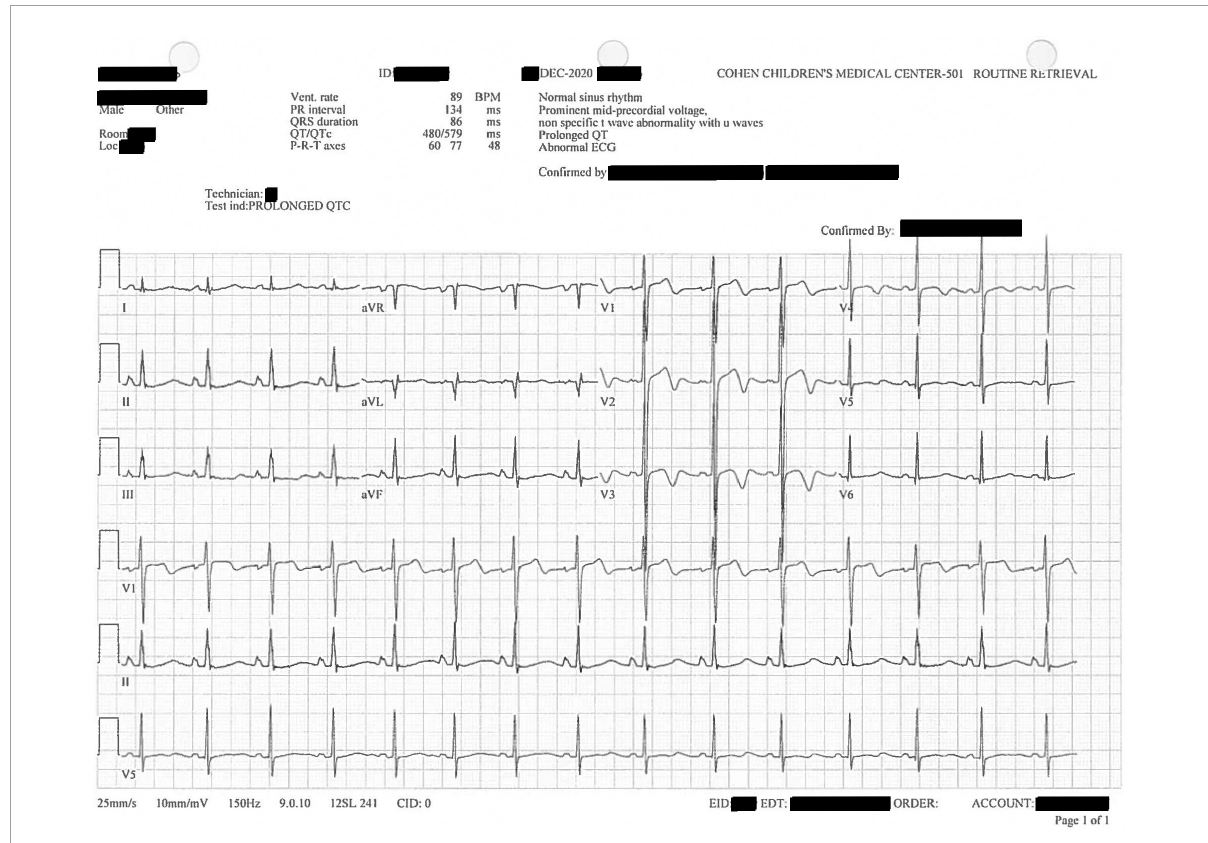
FIGURE3 Confirmatory, diagnostic twelve-lead electrocardiogram replicating prior findings of V1–V4 U waves and prolonged QTc, here 579